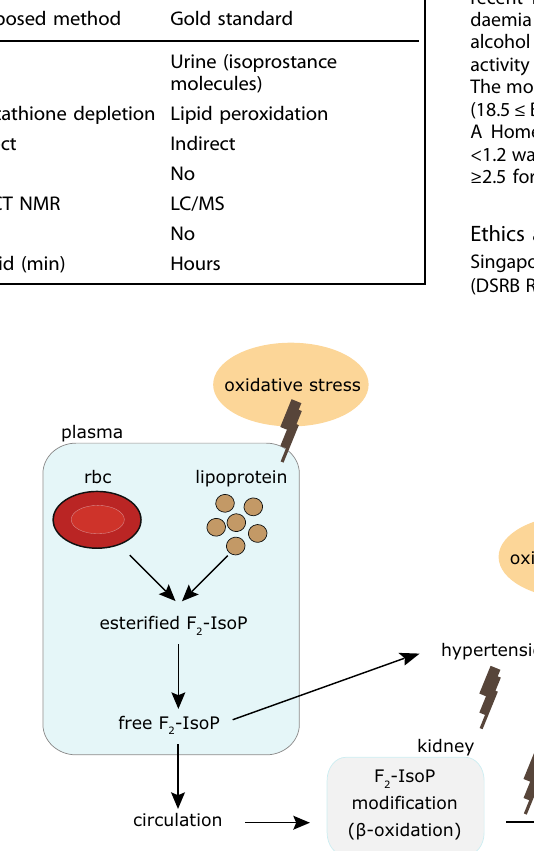
Fig. 9 Schematic representation of the conceptualized mechanism of oxidative stress. Free F 2 -IsoP was formed from the esteri fi ed to phospholipids in RBCs and lipoprotein membranes in plasma. Free F 2 -isoP was then rapidly metabolized by the kidney and excreted in urine with its metabolites. Oxidative stress may affect the levels F 2 -IsoP directly but the downstream urinary F 2 -IsoP level may be modi fi ed indirectly by a series of events, including the kidney function, and hypertension.